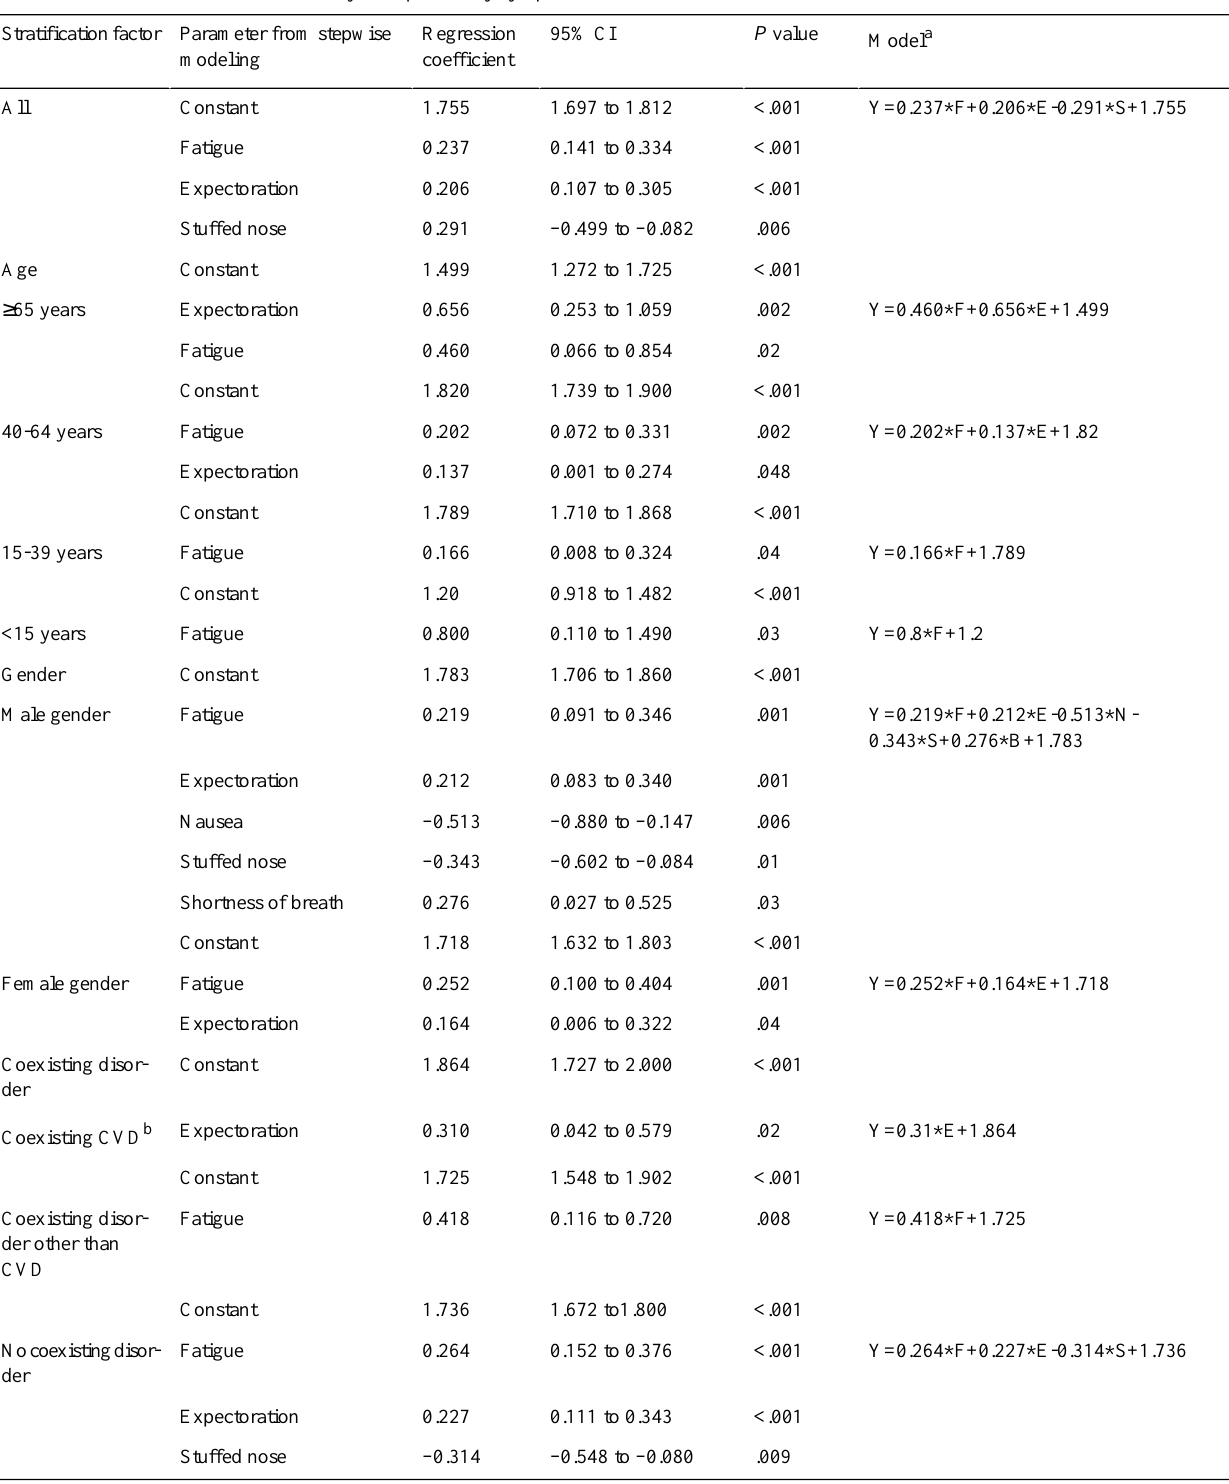
Table 3. Linear models of clinical severity as explained by